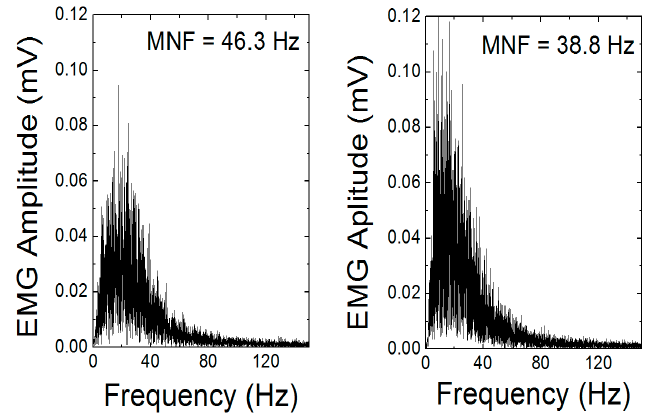
Figure 7. Power signal density. Amplitude and mean frequency mean frequency (MNF) shift of power signal density (PSD) due to fatigue.